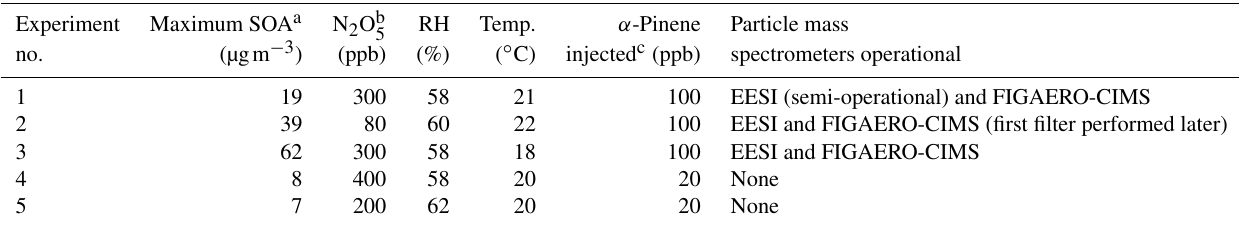
Table 1. Experimental parameters. Experiment Maximum SOA a N 2 O b